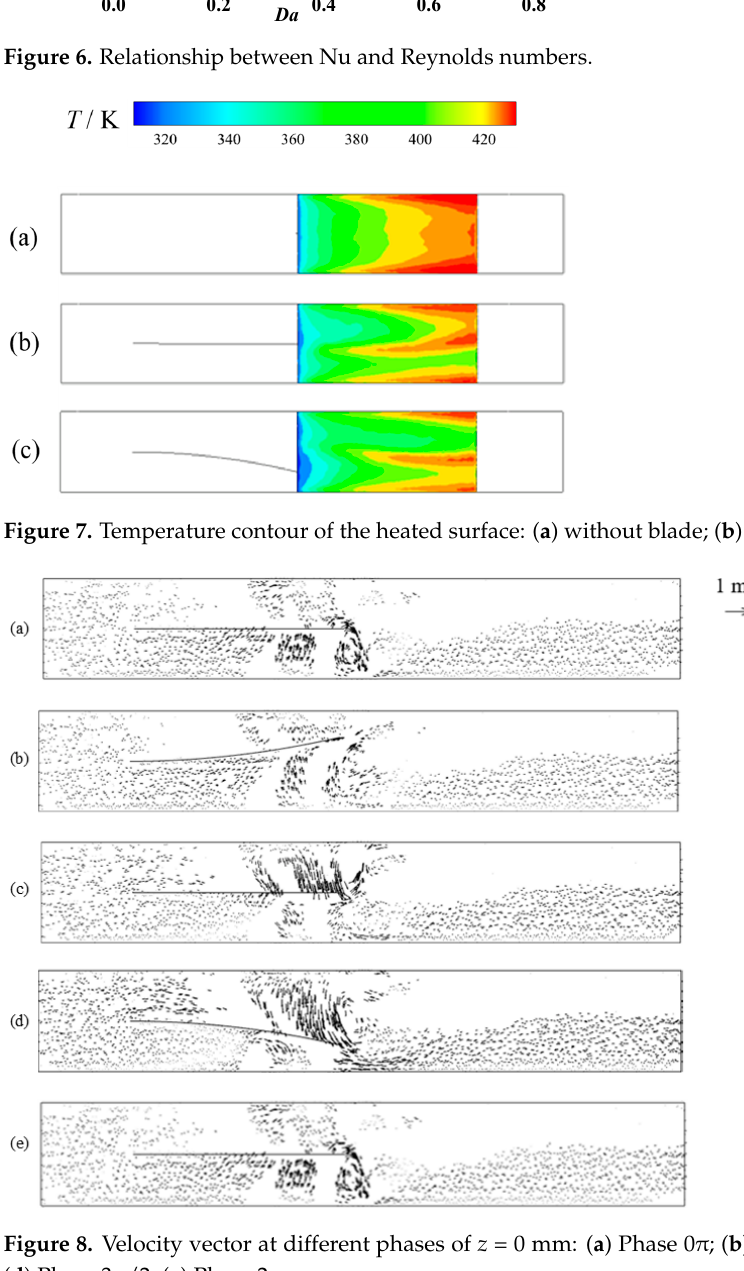
Figure 8. Velocity vector at different phases of z = 0 mm: ( a ) Phase 0 π ; ( b ) Phase π /2; ( c ) Phase π ; ( d ) Phase 3 π /2; ( e ) Phase 2 π . ( d ) Phase 3 π /2; ( e ) Phase 2 π